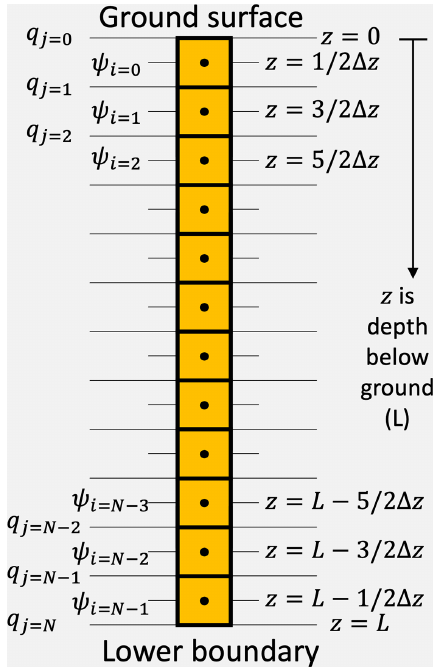
Figure 1. Schematic representation of the cell-centered finite- difference grid, for a soil column of depth L , showing the zero- based Python indices of the states ( ψ i ) and fluxes ( q j ) on the left and depths of the nodes on the right, assuming a regular grid. There are N states and N + 1 fluxes. The upper- and lower-boundary con- ditions are q j = 0 and q j , N